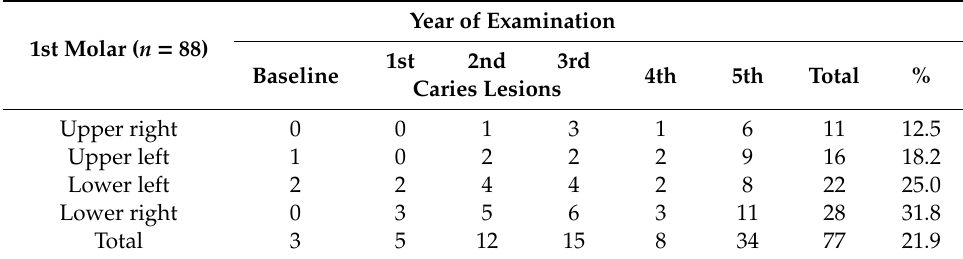
Table 2. New caries lesions in first permanent molars during each year of follow-up.